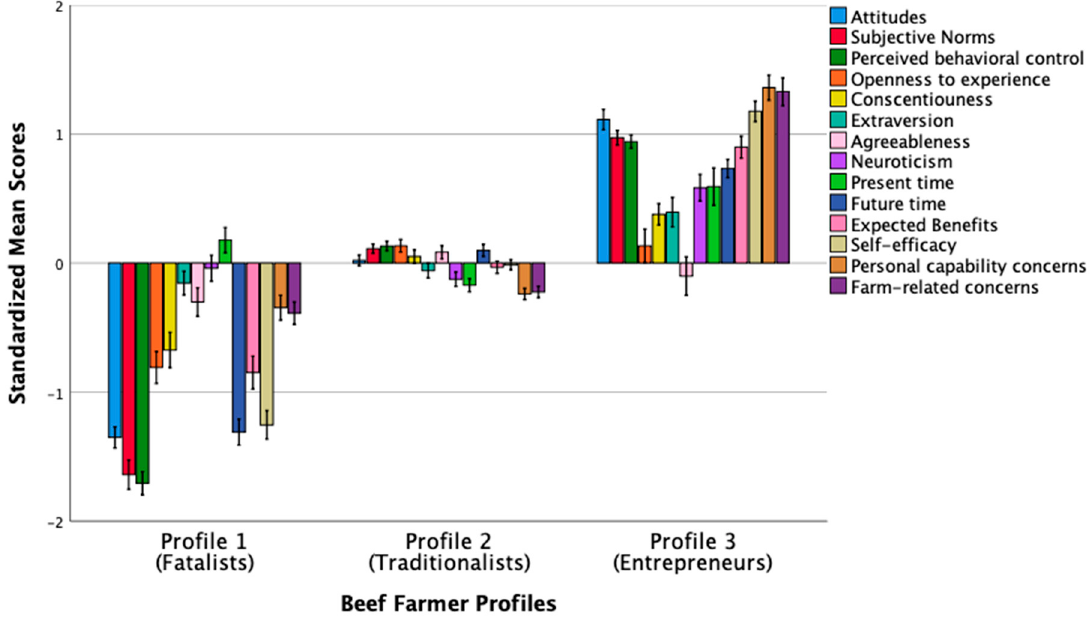
Figure 2. Profile of beef cattle farmers (Profile 1, n = 67; Profile 2, n = 329; Profile 3, n = 75; Reprinted with permission from [9]. 2023. Bhullar et al.